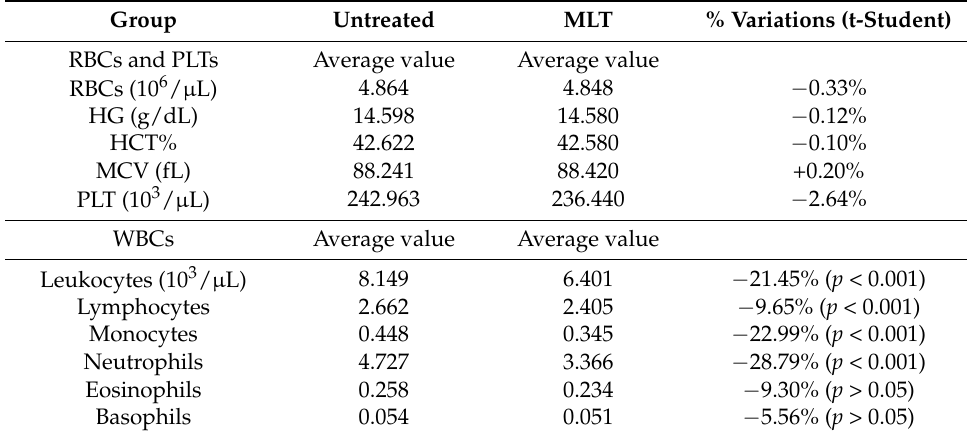
Table 4. Comparison of hemocytometric parameters untreated group vs. MLT group (morning data). Group Untreated MLT % Variations